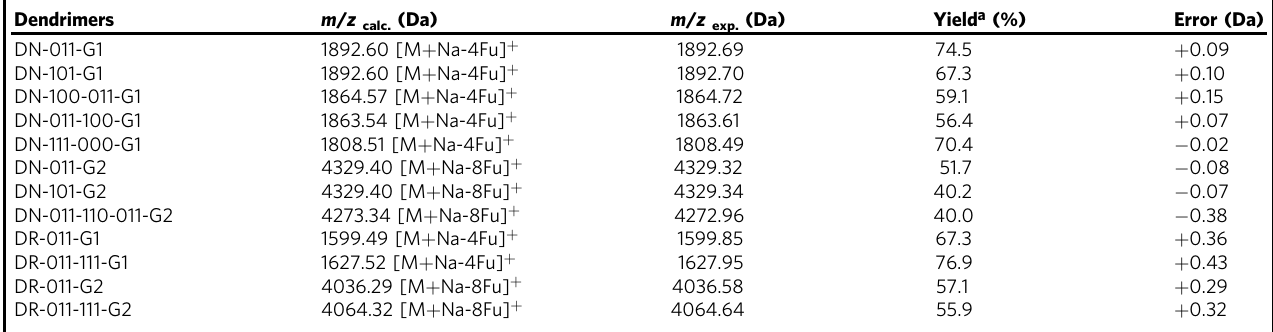
Table 1 Isolated yields and MALDI-TOF MS data of dendrimers Dendrimers